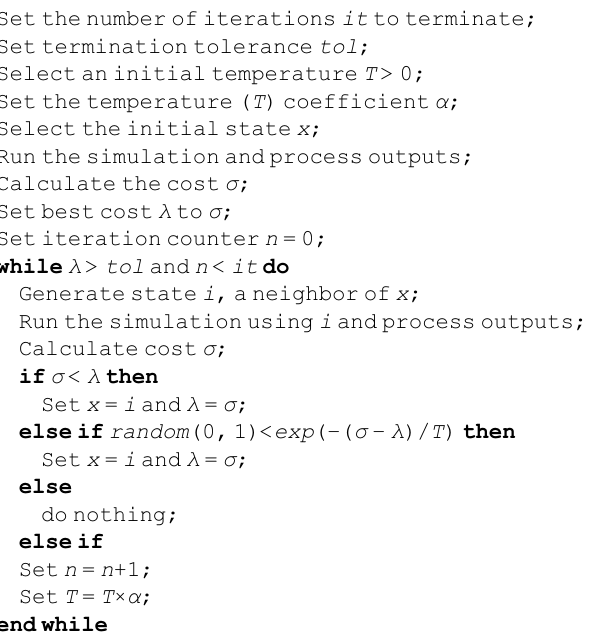
Algorithm 1 Calibration Algorithm Pseudo-code